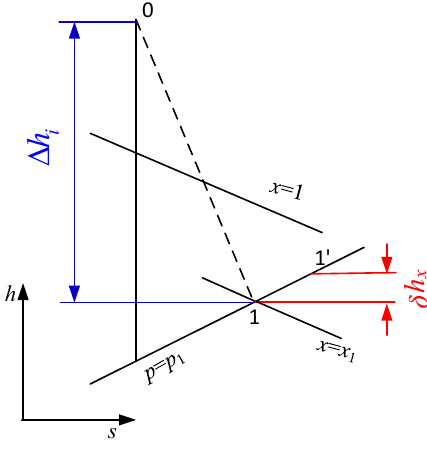
Figure 1. Schematic diagram of wetness losses.